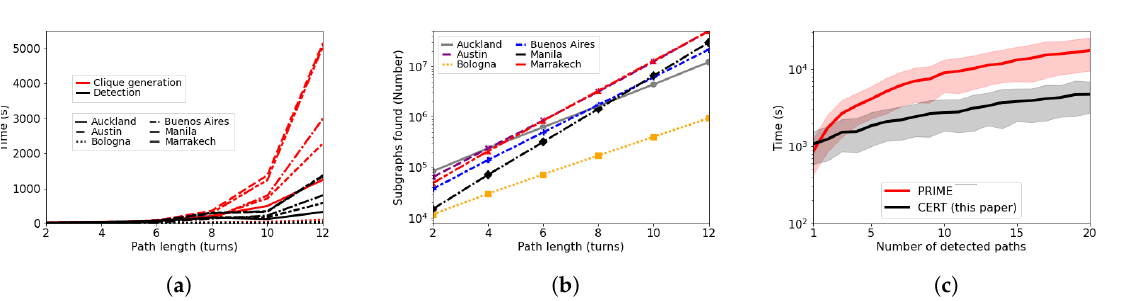
Figure 7. ( a ) shows the time needed to perform the clique generation and the detection for different cities worldwide. ( b ) shows the number of different subgraphs found for the same cities, versus the length of the path. Finally ( c ) shows the comparison in time between this work and